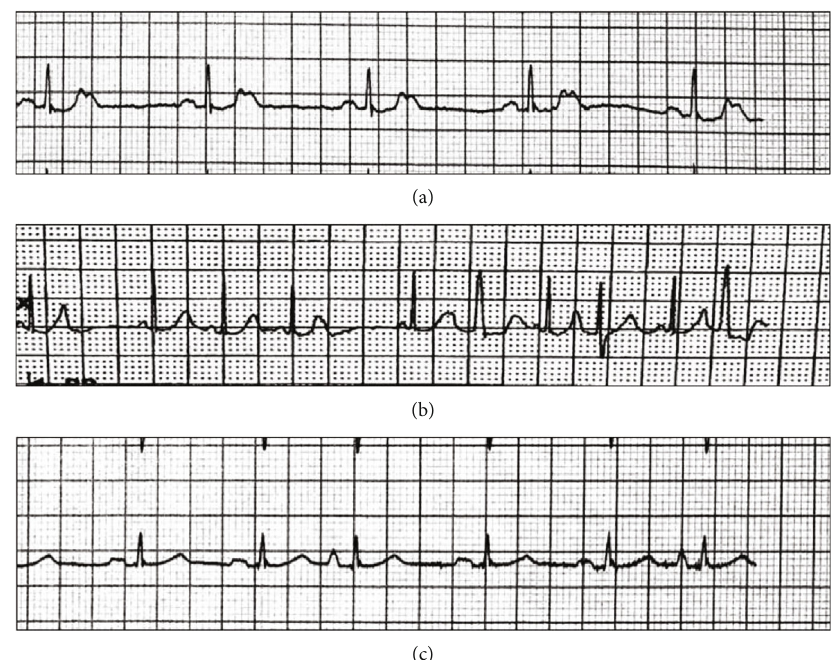
Figure 1: Representative lead II ECG tracings. ECG from day 1 (a), prior to convalescent plasma treatment (b), and after convalescent plasma treatment (c). The ectopy that presented during hospitalization was nearly resolved following treatment with convalescent